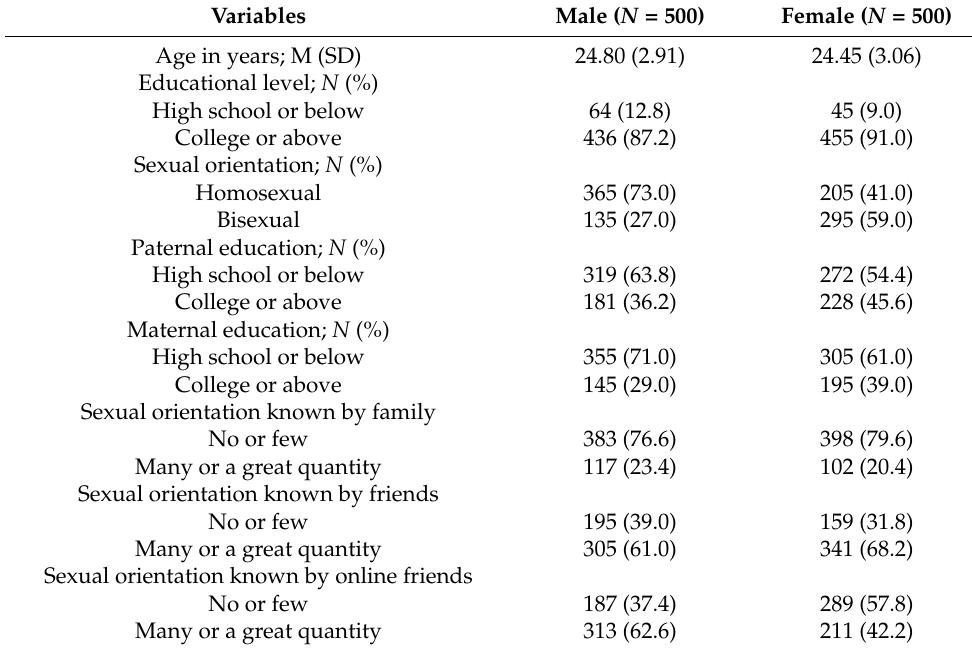
Table 1. Participants’ characteristics ( N = 1000).